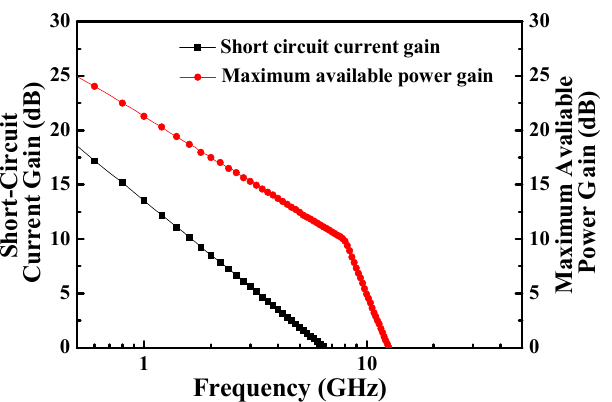
Figure 6. Under the operation of drain−source voltage of 10 V, drain−source current and extrinsic transconductance as a function of gate−source voltage of MOSHEMTs with multiple-mesa-fin-chan- nel array.